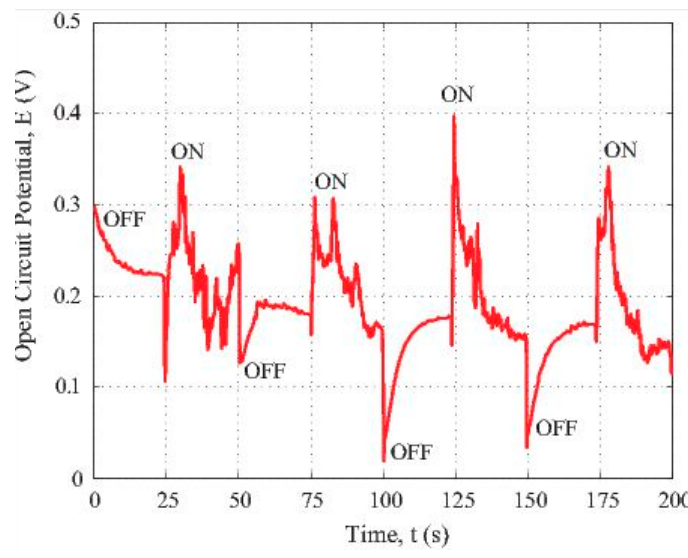
Figure 4. Photosensitivity of the iron oxide loaded carbon fiber under visible light excitation.